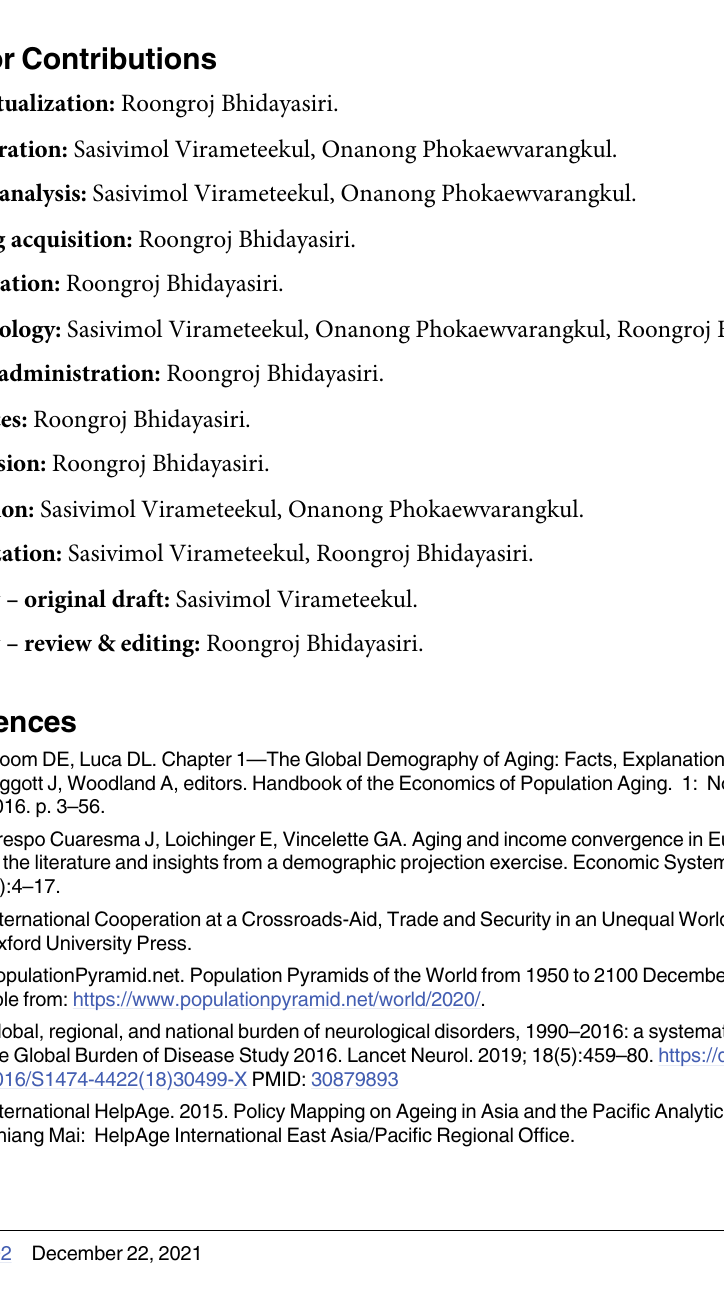
S3 Table. Correlation of various variables with age and disease duration. UPDRS, Unified Parkinson’s Disease Rating Scale; H&Y, Hoehn & Yahr; NMSQuest, Non-Motor Symptoms Questionnaire; TMSE, Thai Mental State Examination; LED, levodopa equivalent dose; S&E-ADL, Schwab and England Activities of Daily Living, CCI, Charlson Cormorbidity Index. a Lower scores indicate greater disability. S4 Table. Logistic regression model for disabilities and milestones. Model summary. a Hos- mer and Lemeshow test 0.403, Nagelkerke R square 0.099. b Hosmer and Lemeshow test 0.782, Nagelkerke R square 0.338. c Hosmer and Lemeshow test 0.406, Nagelkerke R square 0.126. d Hosmer and Lemeshow test 0.449, Nagelkerke R square 0.129. e Hosmer and Leme- show test 0.034, Nagelkerke R square 0.044. f Hosmer and Lemeshow test 0.972, Nagelkerke R square